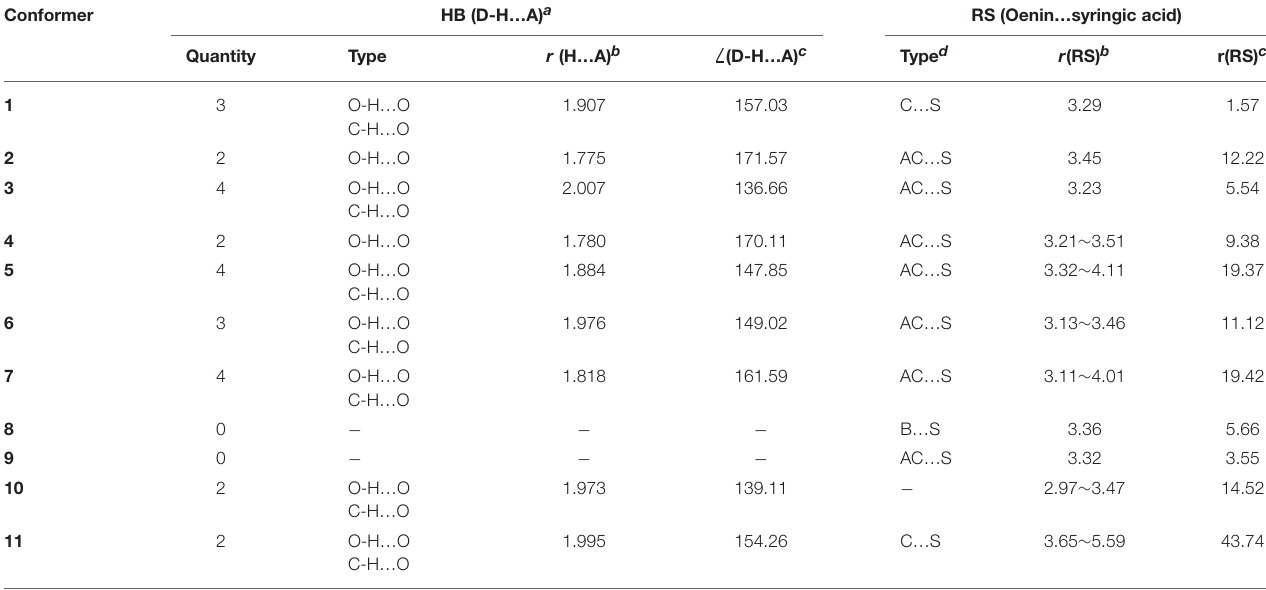
TABLE 1 | Hydrogen-bonding (HB) and ring-stacking (RS) parameters (distance in angstrom, angle in degree).